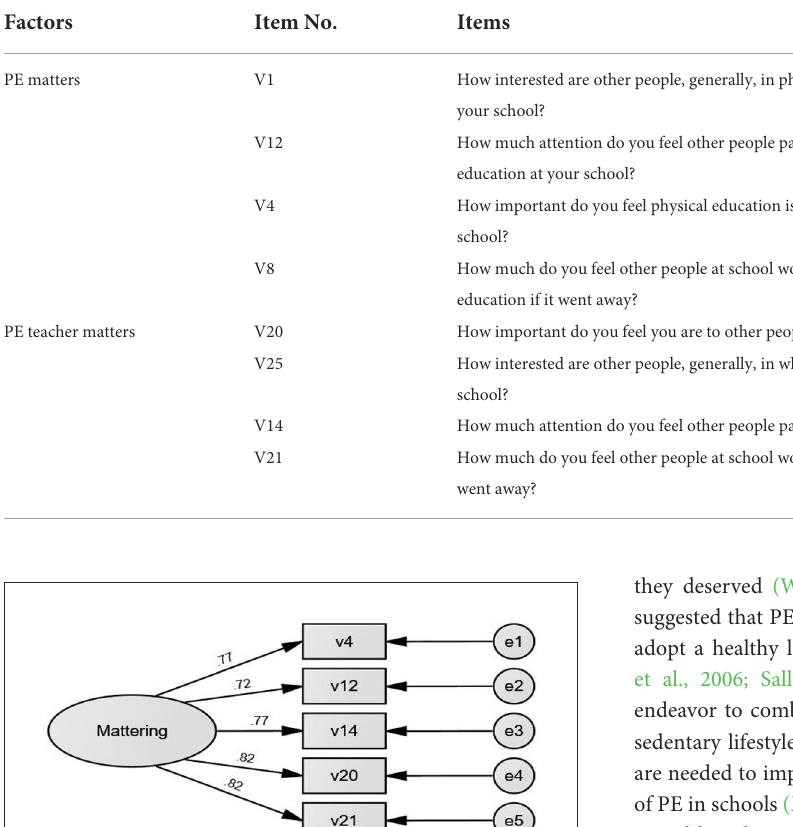
TABLE 2 Factors and items in PMQ-PEC and factor loadings of EFA using sample A.